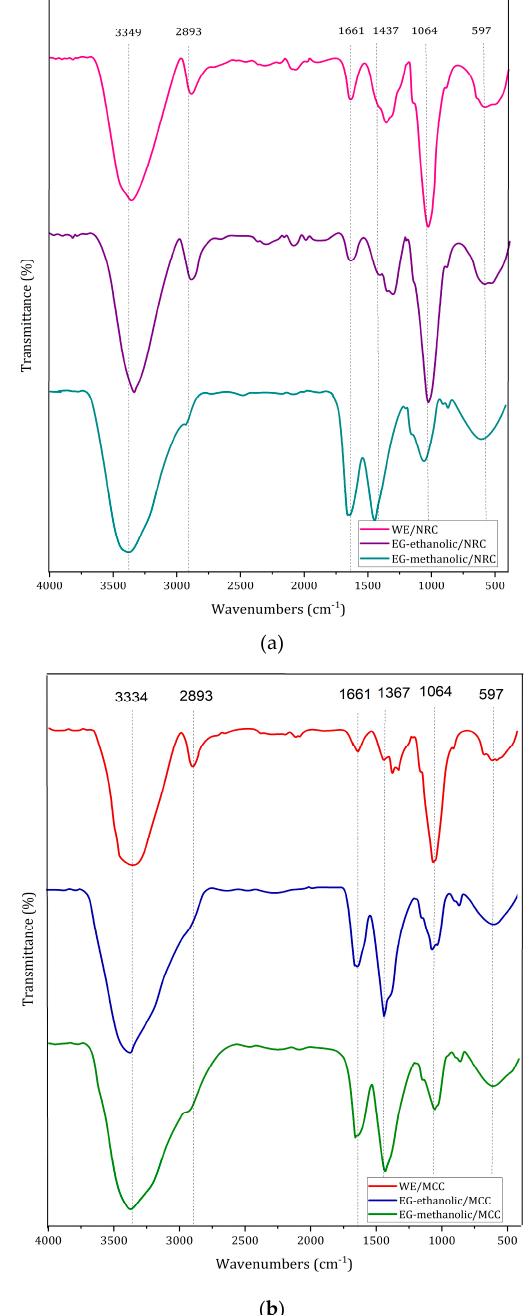
Figure 8. FT-IR spectrum of loaded-hydrogels compared with without extract ( a ) NRC type and ( b ) MCC type.